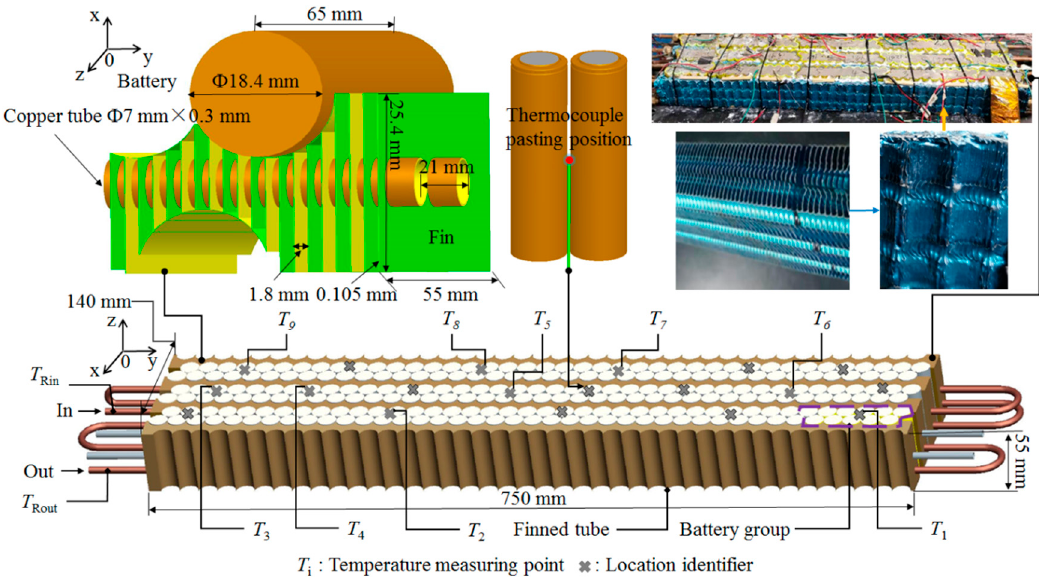
Figure 1. Schematic of the battery module.